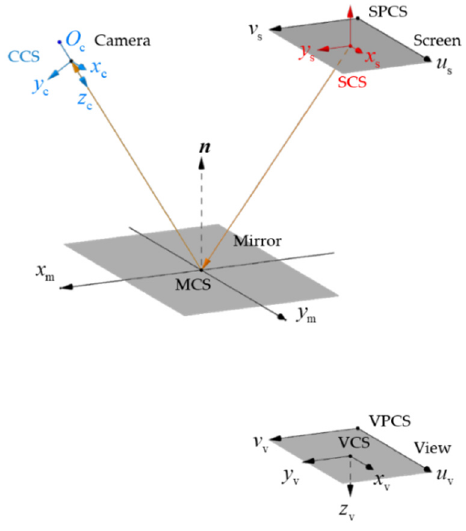
Figure 2. The distributions of the coordinate systems in the MPMD measuring system. The direction of the optical path can be analyzed reversely in the MPMD system.